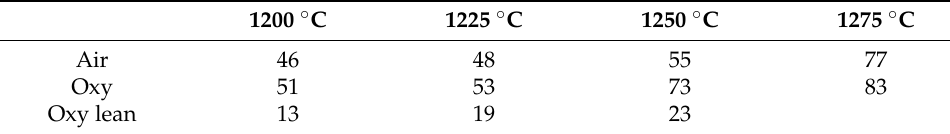
Table 4. GDOES measured depth for the inner oxide layer, in µ